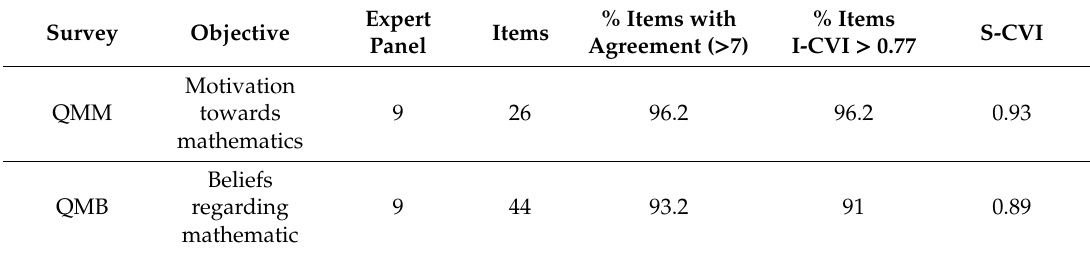
Table 3. The outcomes of the study of the item-rated content validity indices (I-CVI) and scale-level-CVI (S-CVI) in the questionnaire of Motivation in Mathematics (QMM) and in the questionnaire about Mathematical Beliefs (QMB).